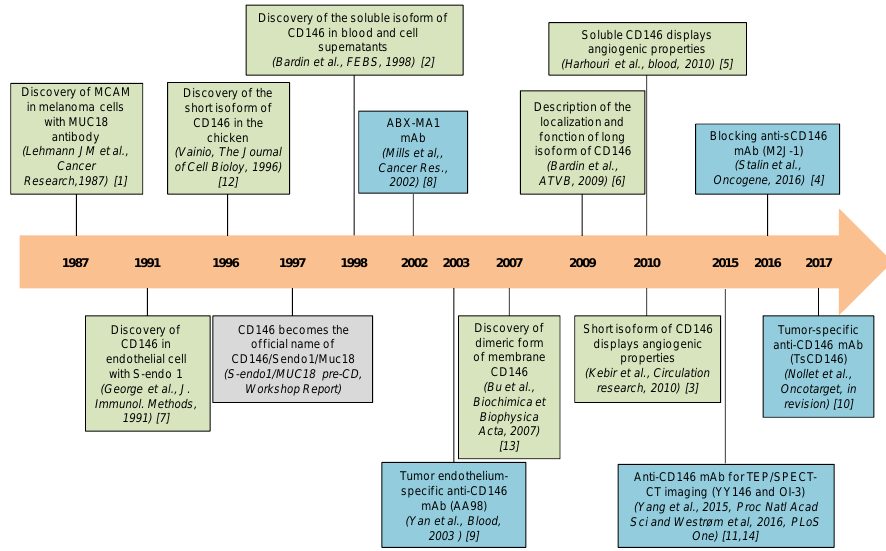
Figure 1. Timeline of research on CD146. This timeline represents the principal discoveries (in green) and antibodies (in blue) related to CD146 [1–14].